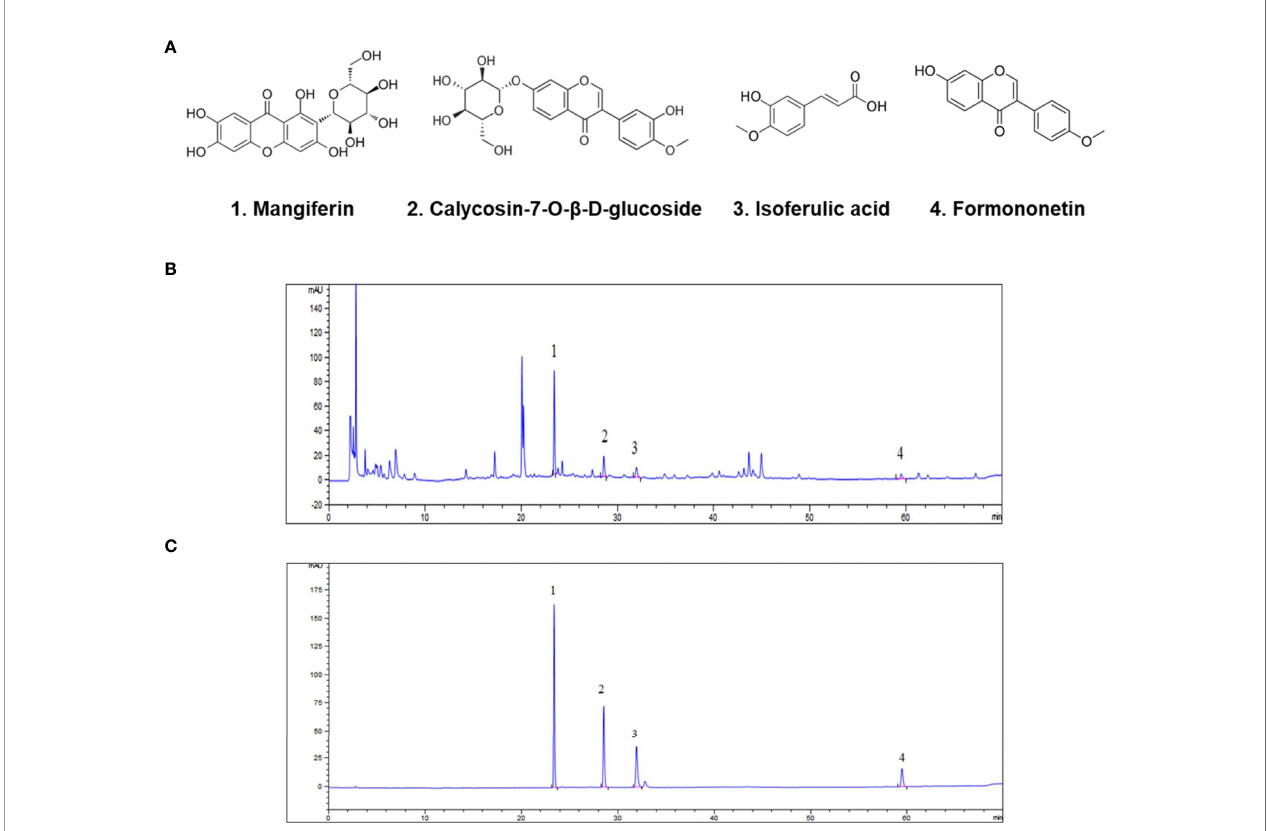
FIGURE 2 | Identi fi cation of anti-cancer phytochemicals in SXT by HPLC analysis. (A) Potential chemical compounds in SXT responsible for anticancer effect. HPLC chromatograms of SXT extract (B) and standard sample mixtures of the potential compounds (C) . Peak assignment as follows: 1. mangiferin; 2. calycosin-7-O- b -D- glucoside; 3. isoferulic acid; 4. formononetin.